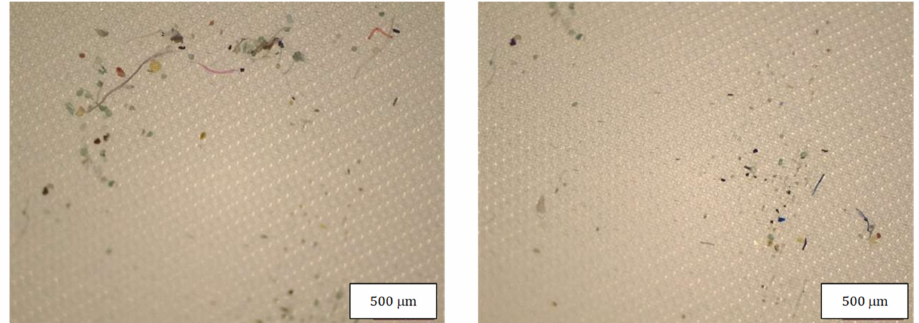
Figure 10. Microplastics detected in the filter of FFP2 N seen at the stereomicroscope with scale bar of 500 µ m.